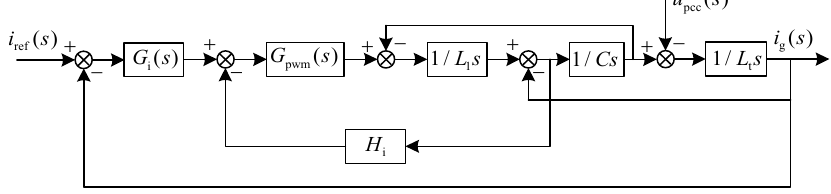
Figure 2. Block diagram of grid-connected inverter under digital control. i ref represents the reference value of the grid current of the α-axis and L t represents